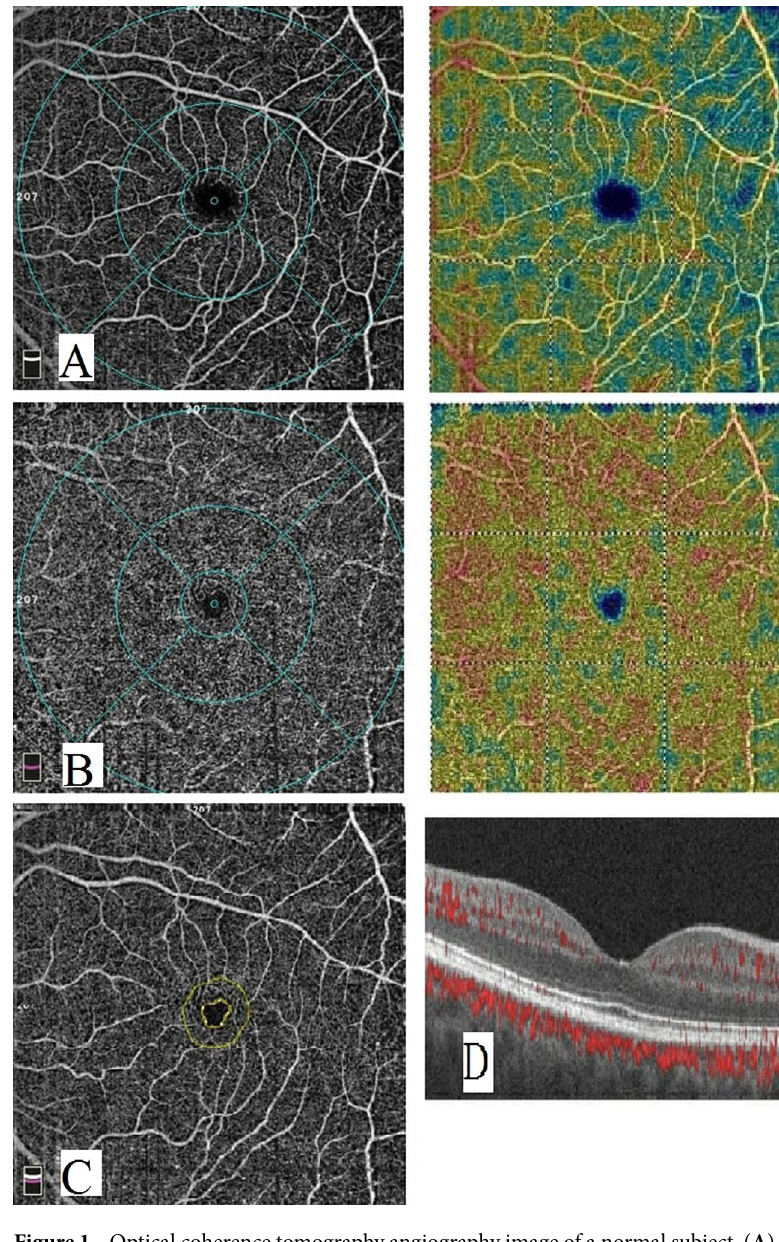
Figure 1. Optical coherence tomography angiography image of a normal subject. ( A ) enface image at the level of SCP. ( B ) enface image at the level of DCP. ( C ) FAZ. ( D ) B scan image showing blood flow at the level of SCP, DCP and